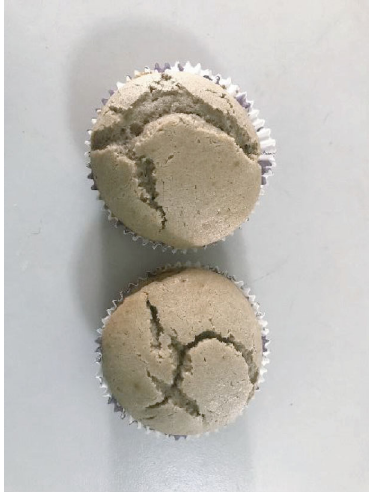
Figure 1: D. alata fl our mu ffi ns without the addition of